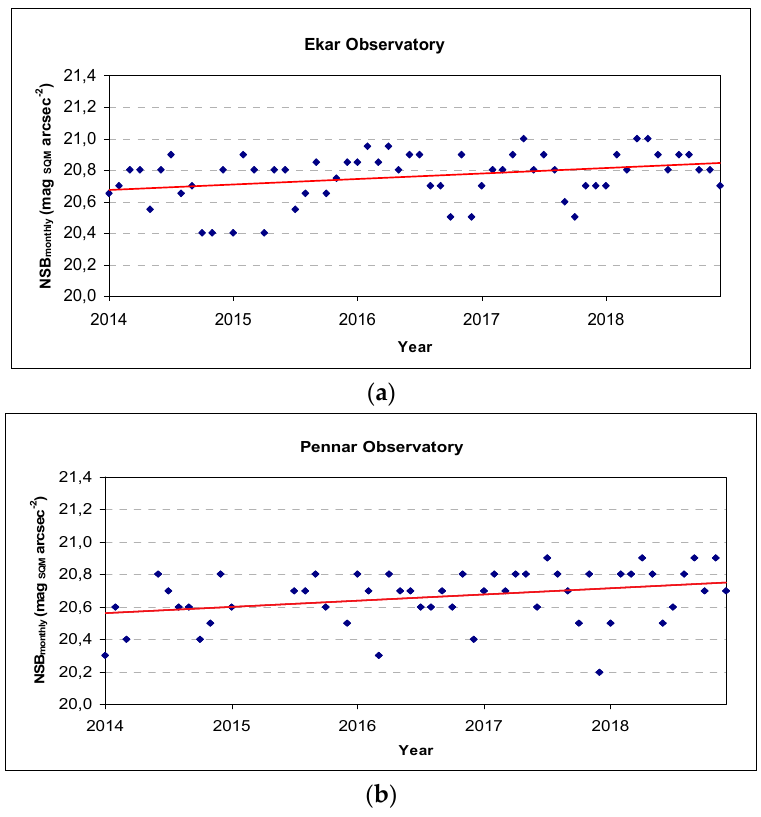
Figure 5. Ekar Observatory ( a ) and Pennar Observatory ( b ) monthly NSB trend.